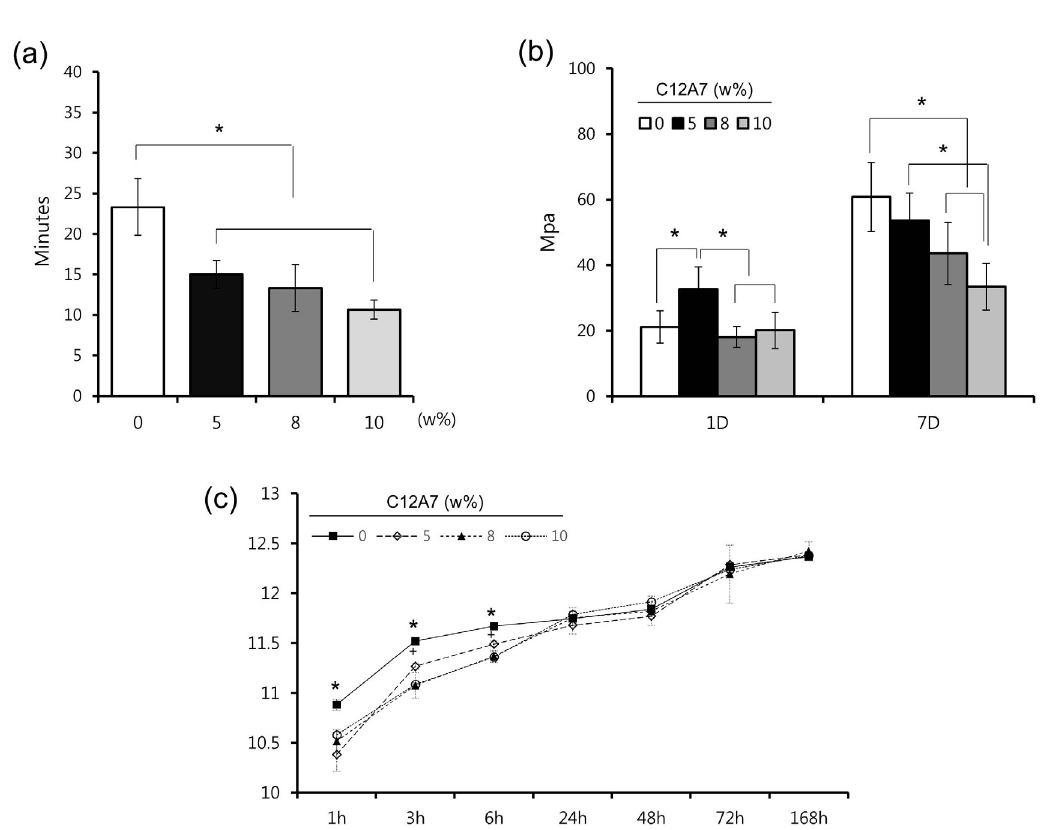
Figure 2- The physicochemical properties of C3S cement containing the various proportion of C12A7; (A) Initial setting time, (B) compressive strength, and (C) pH. statistical significance was determined at